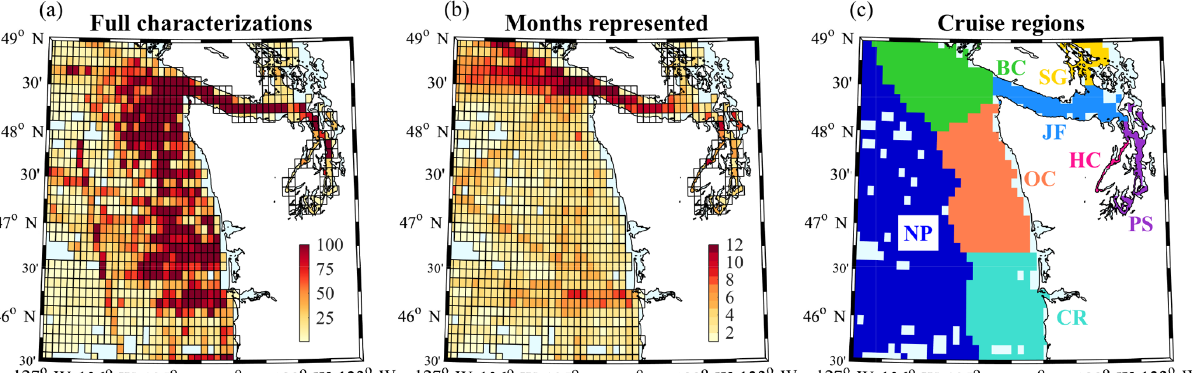
Figure 2. Maps showing (a) the total number of times the carbonate system was fully characterized (two parameters available) in each grid cell, (b) the number of months represented in the seasonal cycle for each grid cell, and (c) the eight unique regions identified, including North Pacific (NP), British Columbia (BC), Outer Coast (OC), Columbia River (CR), Juan de Fuca (JF), Strait of Georgia (SG), Hood Canal (HC), and Puget Sound (PS).